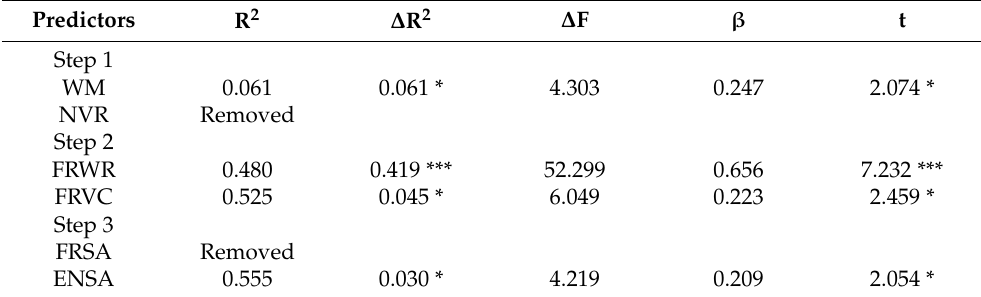
Table 3. Hierarchical stepwise regression analyses examining the role of receptive vocabulary, word reading, and syntactic awareness in French reading comprehension ( n =